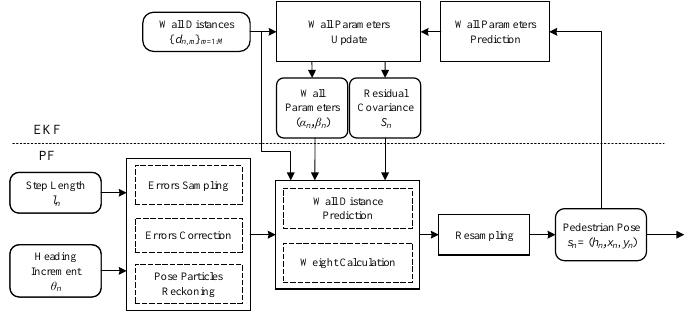
Figure 8. Flow chart of the PF-EKF